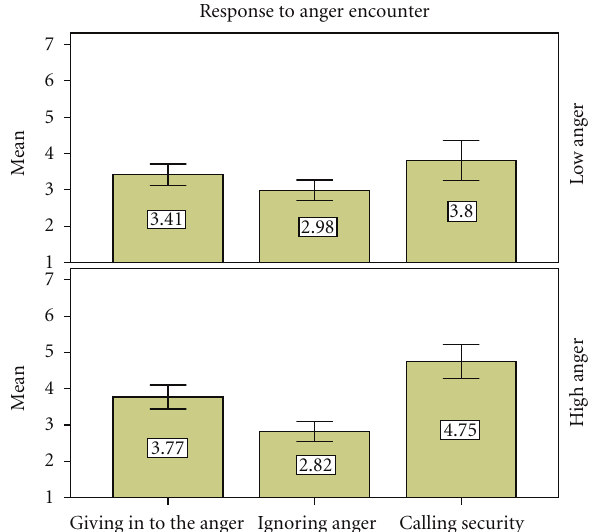
Figure 1: Response to anger encounter. The participants indicated on a 1–7 point scale the likelihood they would respond in one of the three ways (1) giving in to anger, (2) ignore the anger, (3) call security. Calling security is the only significant di ff erence between the high and low anger ( F (1,141) = 6.91, P < 0 . 05).